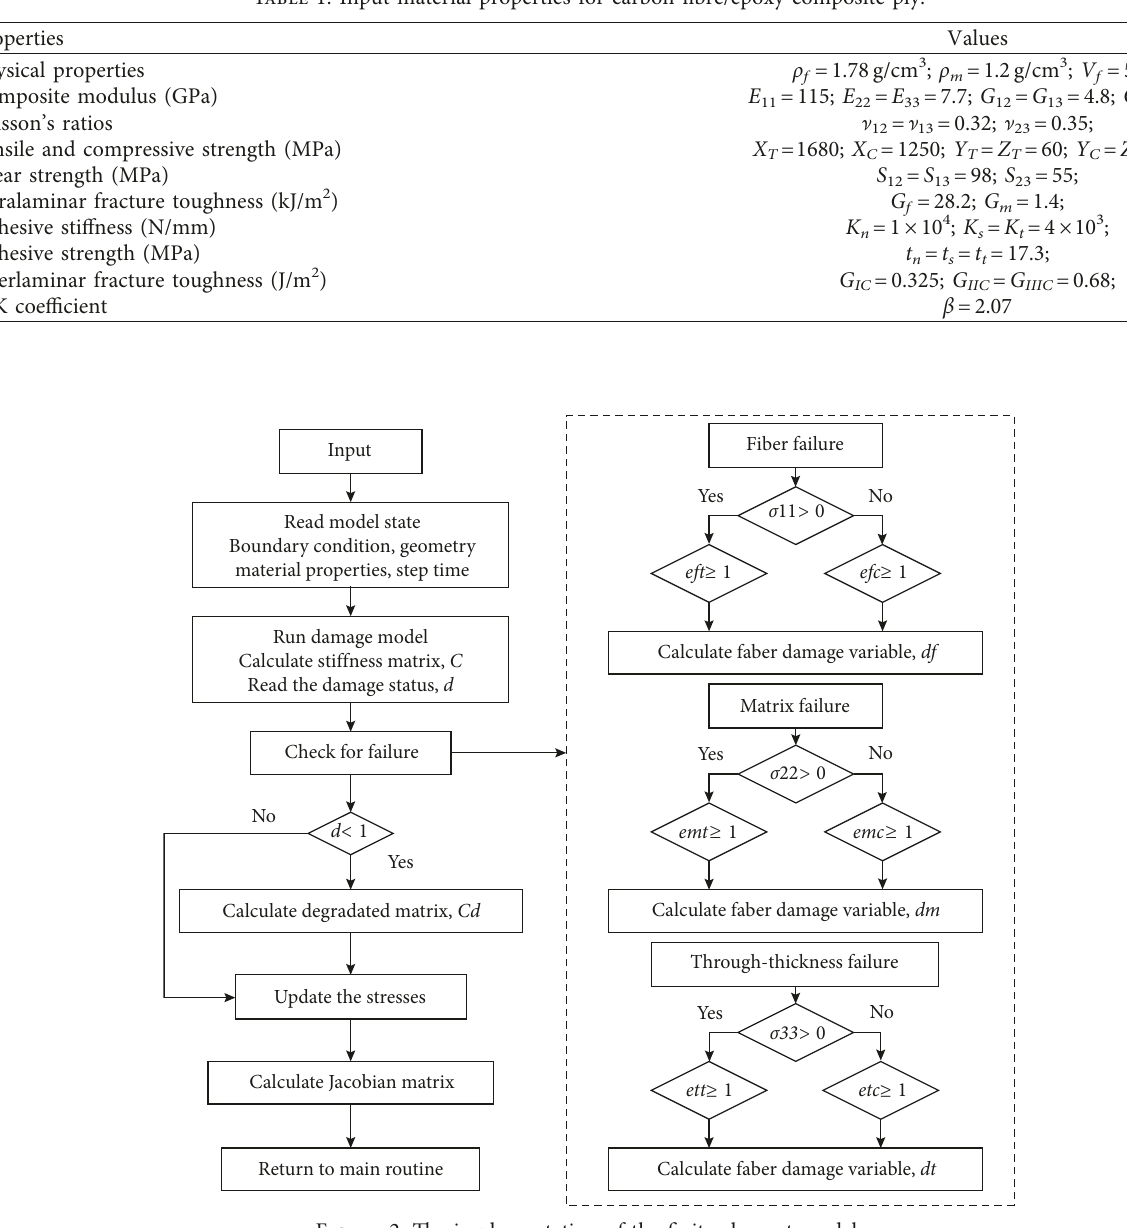
Figure 2: The implementation of the finite element